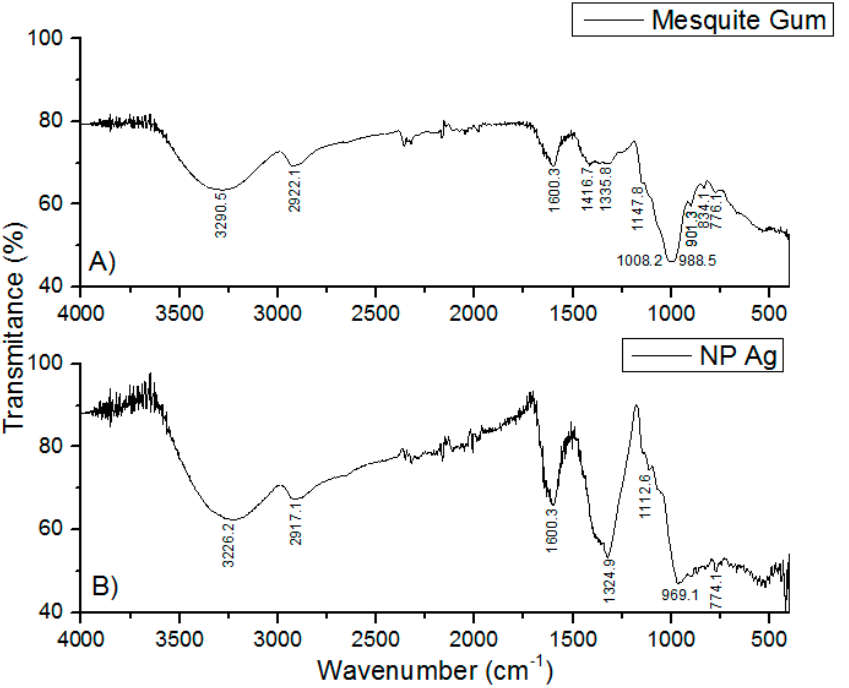
Figure 4. IR spectra of: ( A ) solid powder of mesquite gum; and ( B ) dried 0.5 mol/L 15 min 1:1 silver NPs.